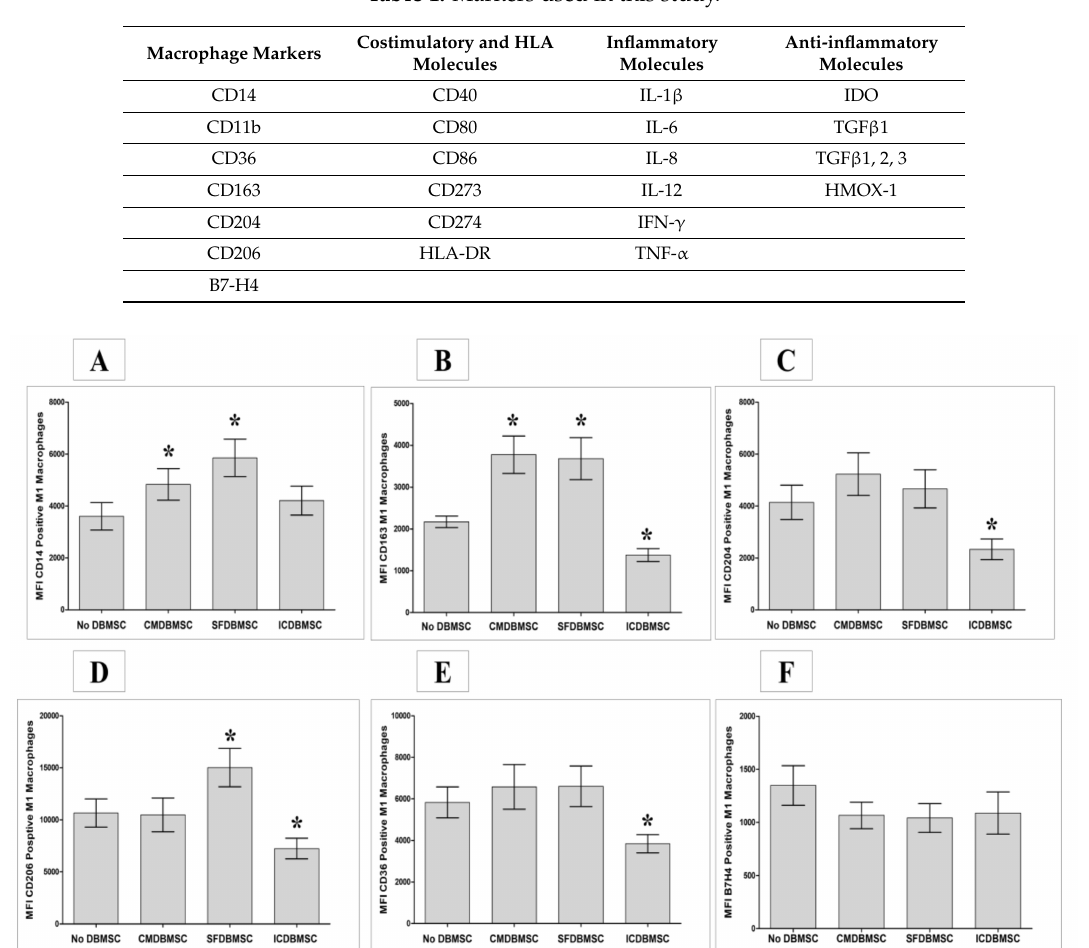
Table 1. Markers used in this study.